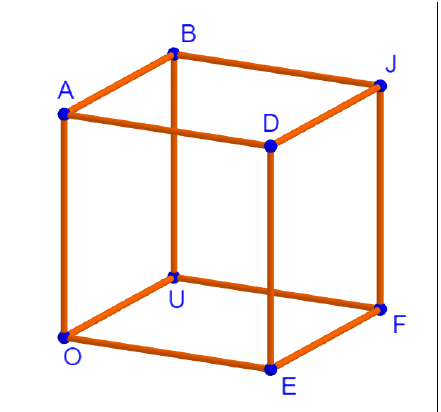
Figure 5. The cubic linkage C